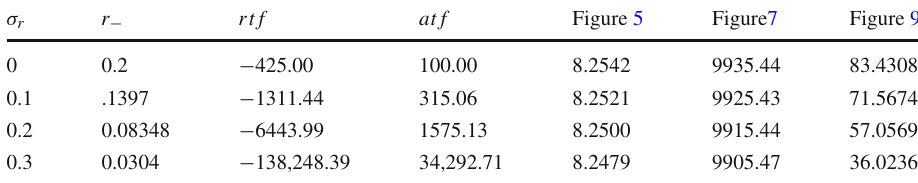
horizon for chosen values of the radiation